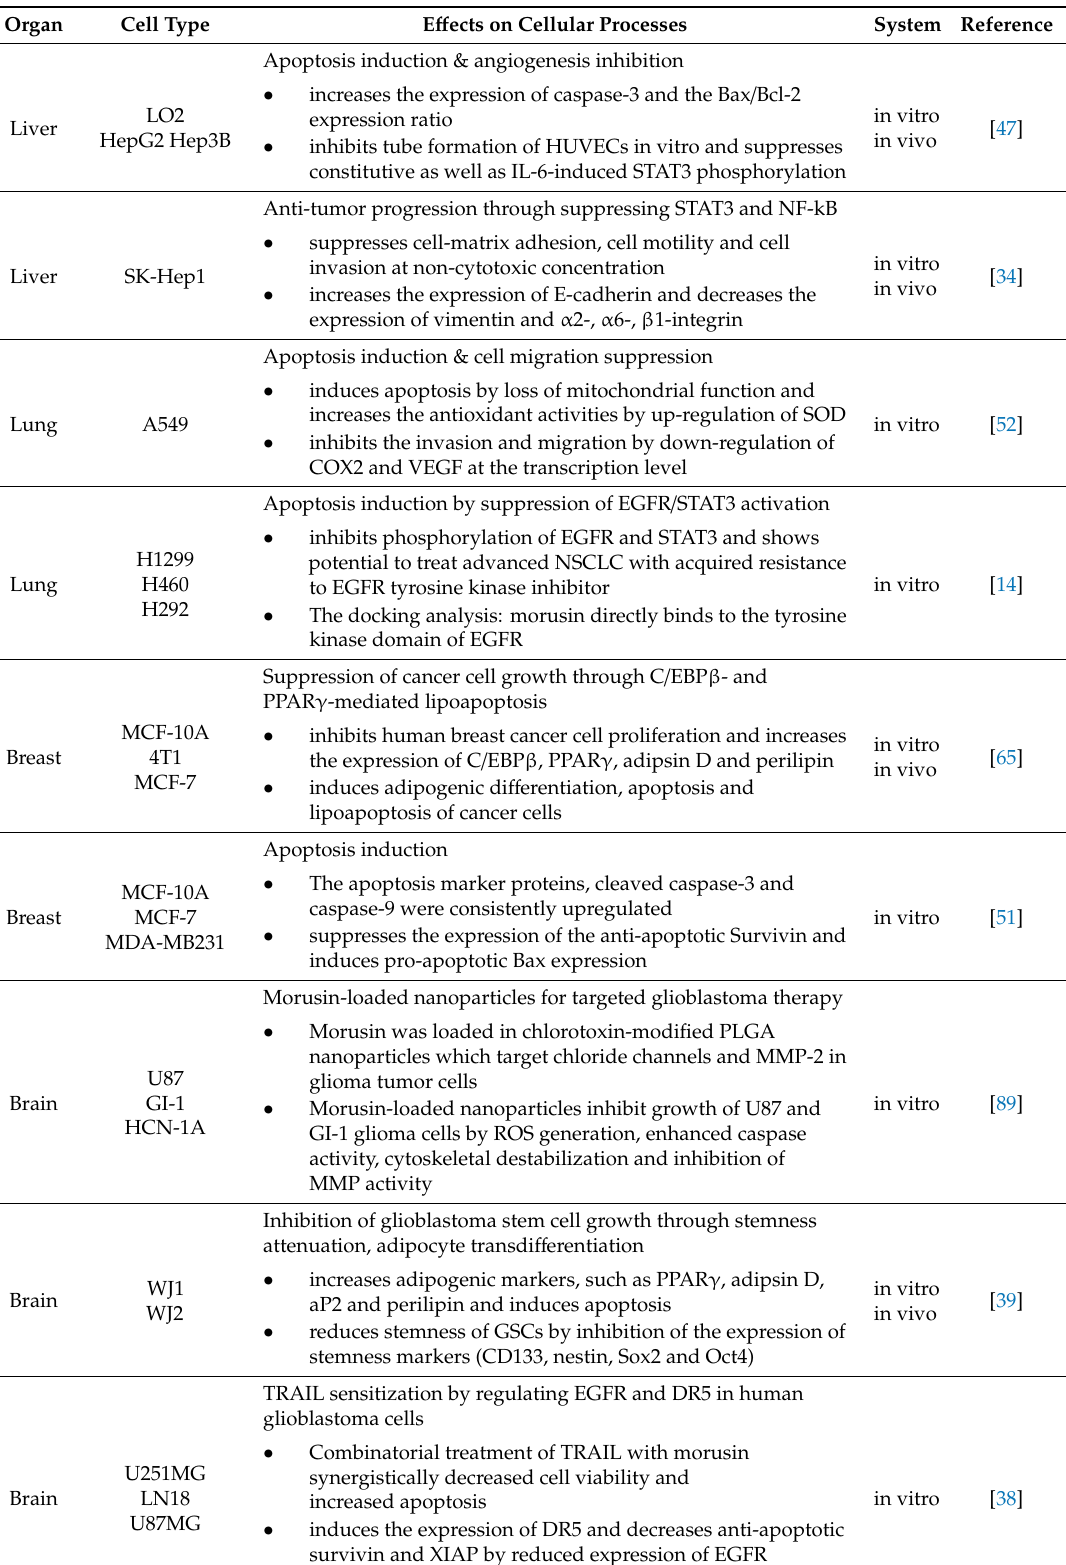
Table 1. The E ff ects of Morusin on Subtypes of